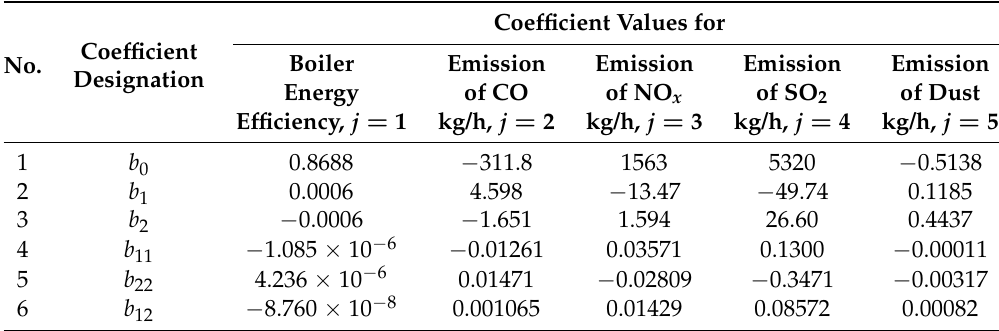
Table 1. Structural parameters of the